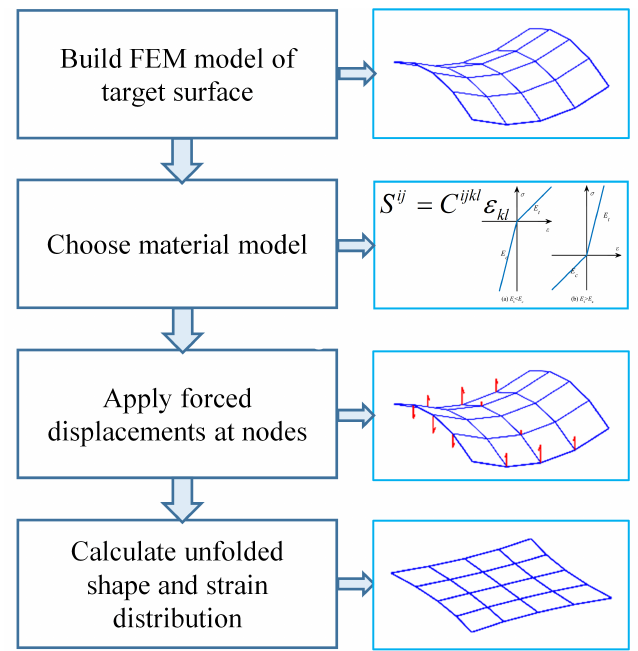
Figure 1. Basic strategy of flattening.